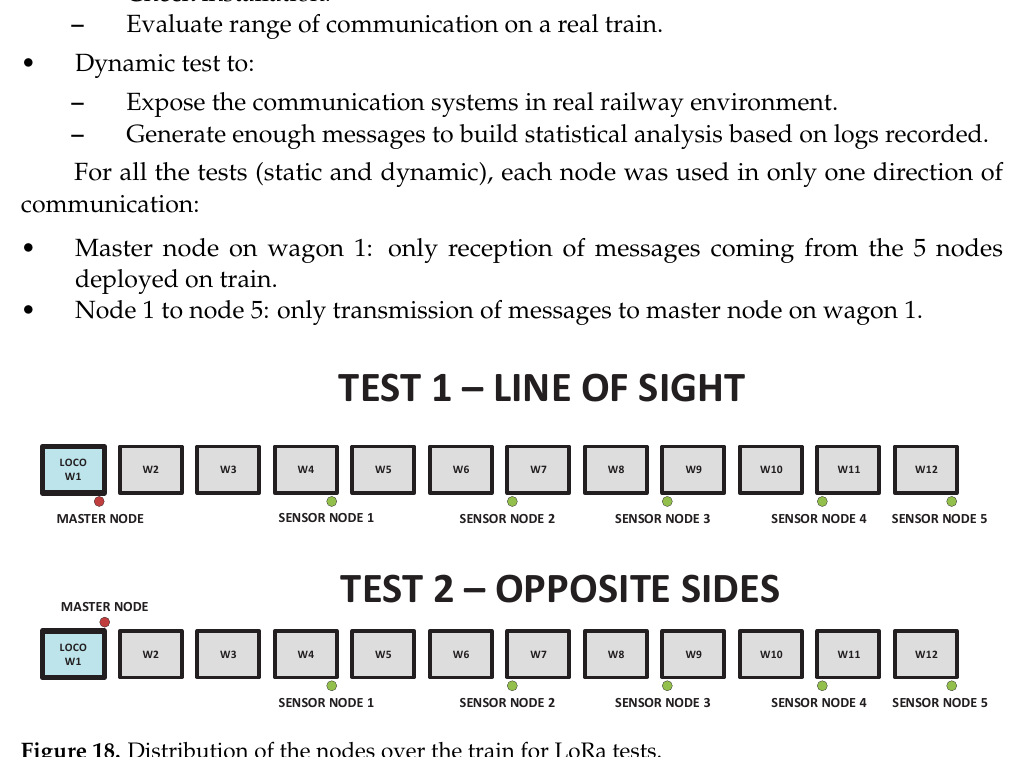
Figure 18. Distribution of the nodes over the train for LoRa